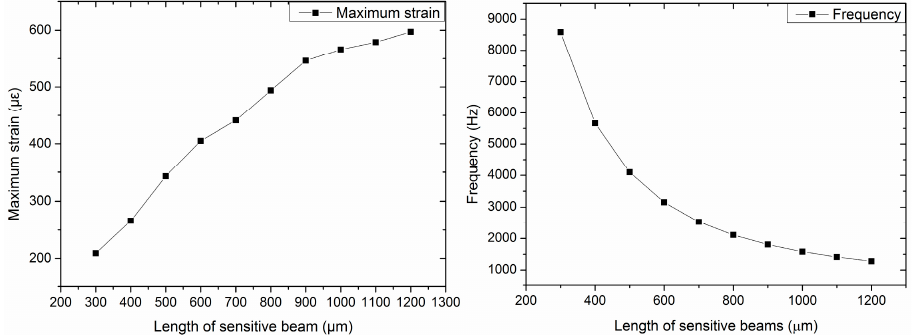
Figure 3. Maximum strain and frequency with different lengths of sensitive beams (thickness is 20 μ m; width is 210 μ m).